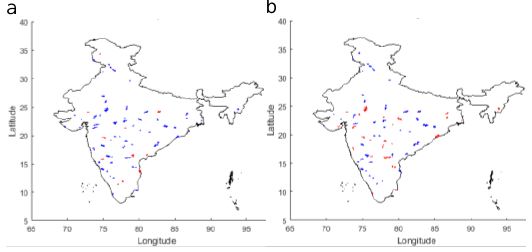
Figure 3: Time series plot of surface water extent derived over Dharoi reservoir, Gujarat from